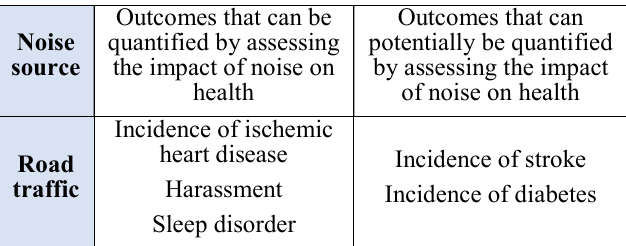
Table 4. Recommended health outcomes for assessing the impact of road traffic noise on the health of residents Noise source the impact of noise on health